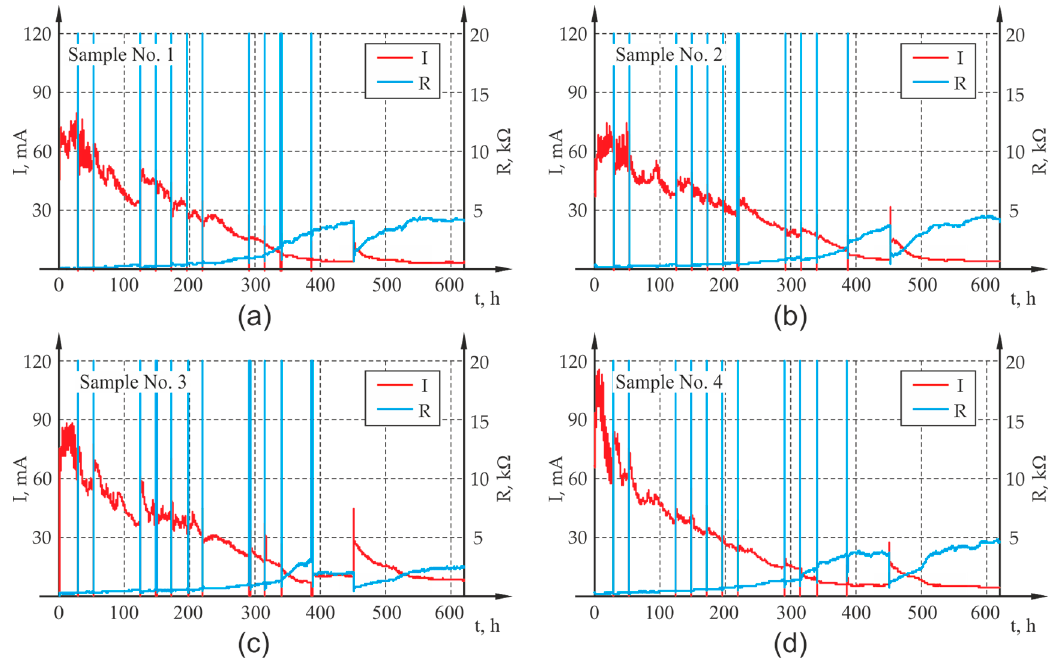
Figure 5. Results of the measurement of current I and electrical resistance of the system R carried out